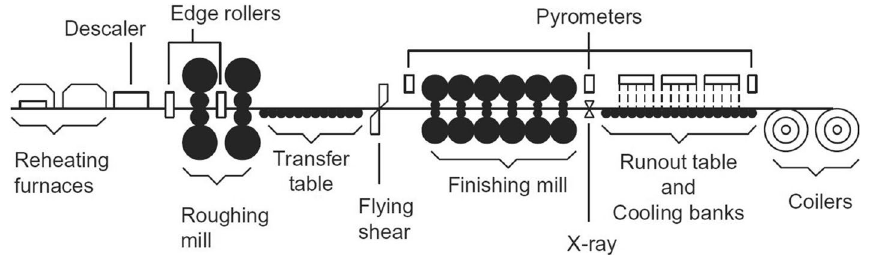
Fig. 1 The schematic diagram of a traditional hot strip